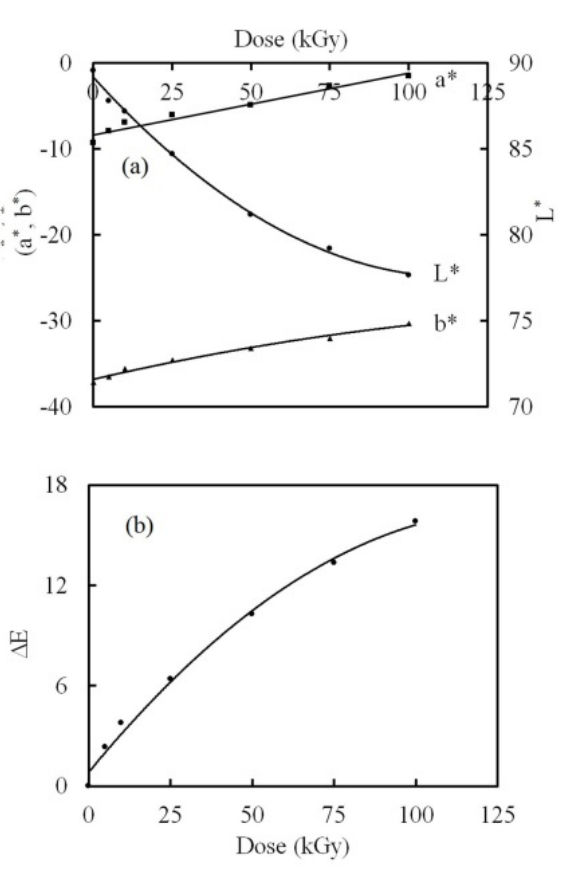
the yellow (+b*) and blue ( − b*). L* expresses the lightness. The white has an L* of 100, and the black has an L* of 0. The precision in computing L* is ± 0.05 and ± 0.01 for both a* and b*, correspondingly. The change in a*, b*, and L* with the γ dose is displayed in Figure 10a. The color intercepts a* and b* showed negative values that increased while raising the dose up 100 kGy. This signifies that the green and blue color components tend to turn into red and yellow, respectively. This was associated with the increase in darkness.